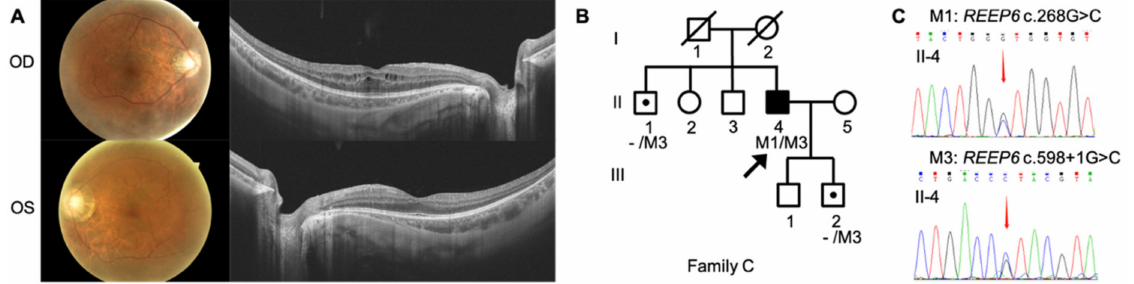
Figure 3. Phenotype and genotype of family C. Heterozygous variants of REEP6 c.268G>C and c.598+1G>C were found in this family. ( A ) Clinical findings of proband C: II-4 including fundus photography and SS-OCT images. ( B ) Pedigree of family C. Black arrows represented the proband. ( C ) Sanger sequencing confirmation of proband C: II-4. Sanger sequencing confirmation of other individuals from family C was shown in Supplementary Figure